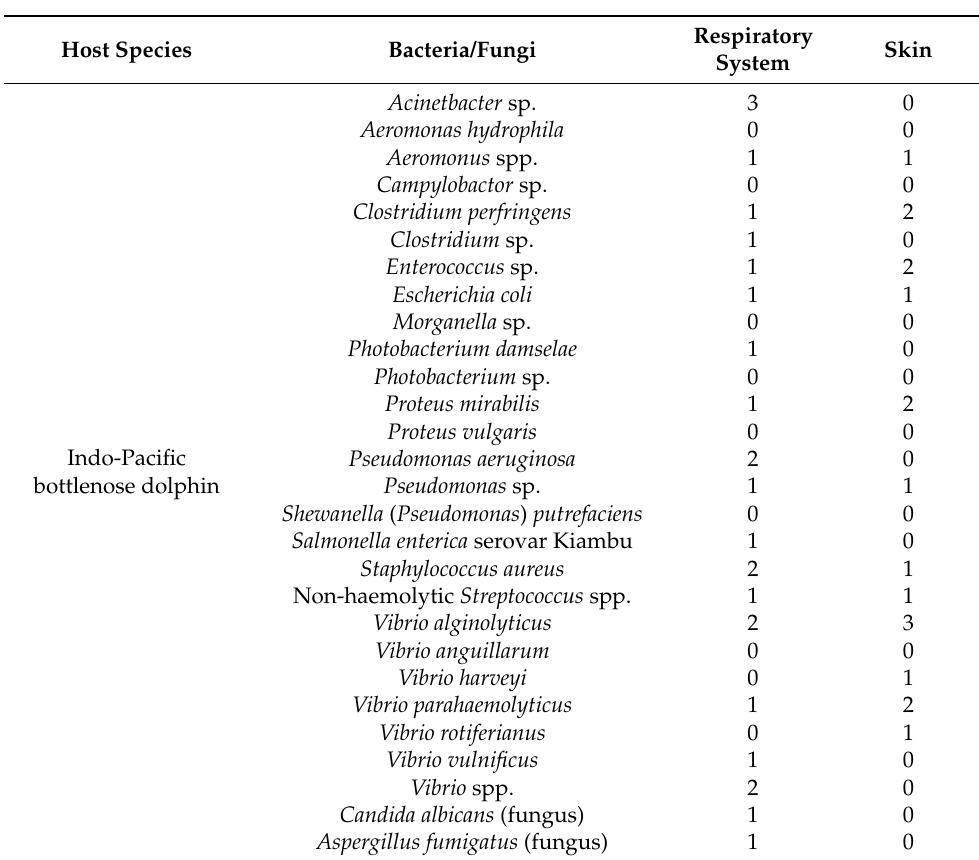
Table A7. Species of bacteria and fungi associated with pathological changes in St Vincent Gulf Bioregion, South Australia, cetaceans during